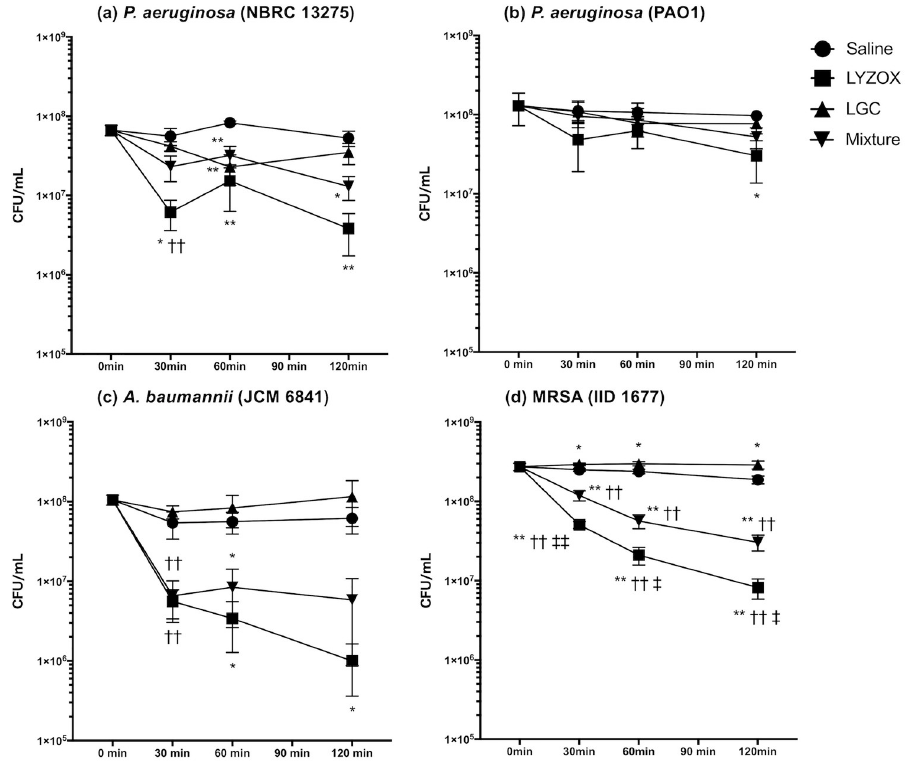
Fig 1. Assays for bactericidal activity. (a) Pseudomonas aeruginosa (NBRC 13275), (b) Pseudomonas aeruginosa (PAO1), (c) Acinetobacter baumannii (JCM 6841), (d) MRSA (IID 1677). Each type of bacteria was incubated with LYZOX solution (2,000 μ g/mL), the mixed solution (lysozyme solution [1,000 μ g/mL] and chitosan oligosaccharide [COS] solution [1,000 μ g/mL]) or the lysozyme-galactomannan conjugate (LGC) solution (2,000 μ g/mL) in saline at 37˚C in a water bath for 0 min, 30 min, 60 min and 120 min. The dilutions were plated, and the colonies were counted following growth overnight. The values are the mean ± SEM from four independent experiments. � p < 0.05 or �� p < 0.01 compared with saline; †p < 0.05 or ††p < 0.01 compared with LGC; ‡p < 0.05 or ‡‡p < 0.01 compared with the mixture (unpaired t-test). Symbols: circles, saline; squares, lysozyme-chitosan oligosaccharide conjugate (LYZOX); up- pointing triangles, LGC; down-pointing triangles,